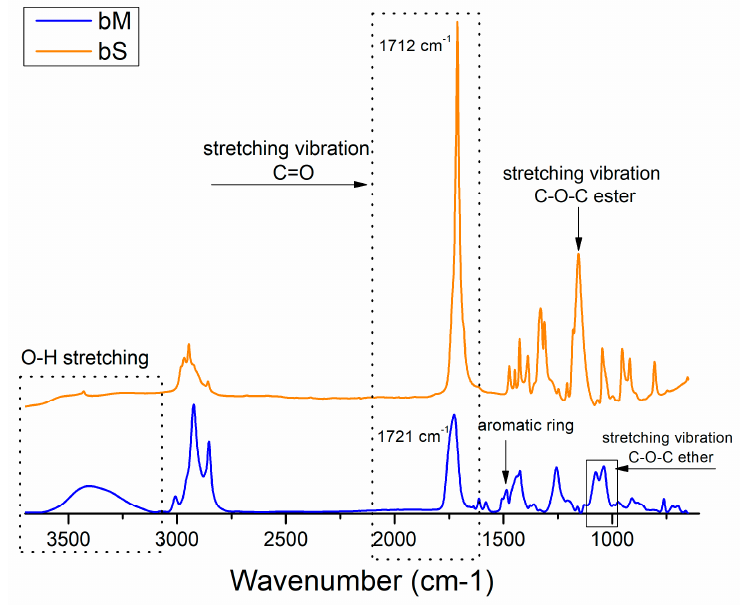
Figure 3. Infrared spectroscopy (FTIR) spectra of bio-based polyols: bS and bM.